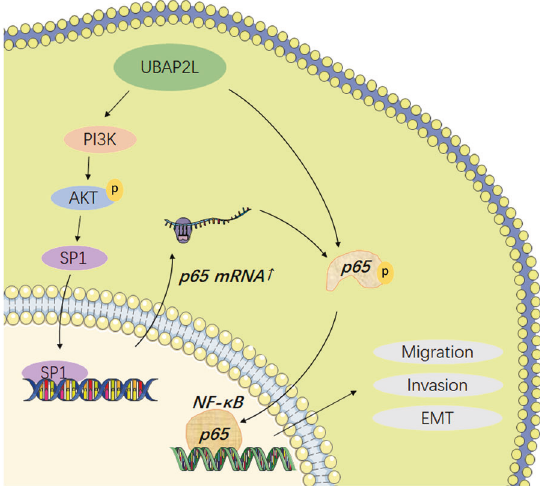
Fig. 7 The regulatory network of UBAP2L in gastric cancer. Aberrant expression of UBAP2L activates p65 through PI3K/AKT/SP1 axis. The increase of p65 nuclear translocation promotes the migration and invasion abilities of GC cells and in fl uences the expression of EMT